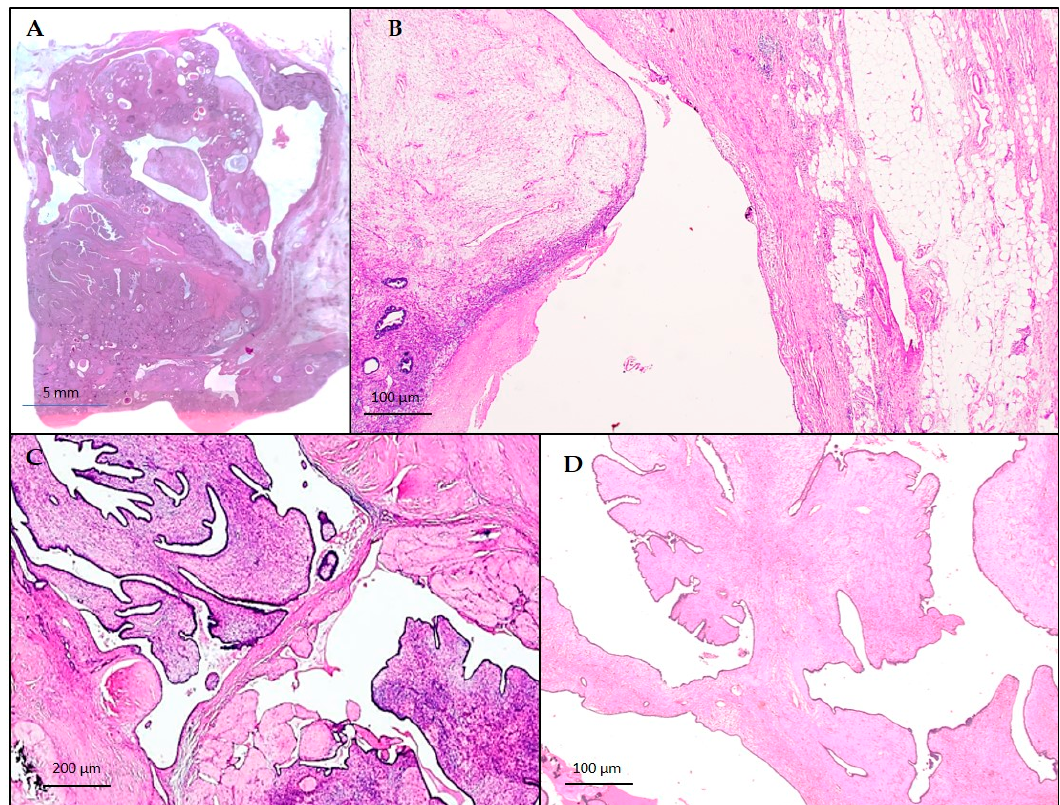
Figure 2. Borderline PT, appearing as a lobulated mass with focally permeating margins ( A ) hematoxylin and eosin, original panoramic view; moderately increased stromal cellularity ( B ) hematoxylin and eosin, original magnification × 50, and leaf-like epithelial pattern ( C , D ) hematoxylin and eosin, original magnification × 25, × 50.